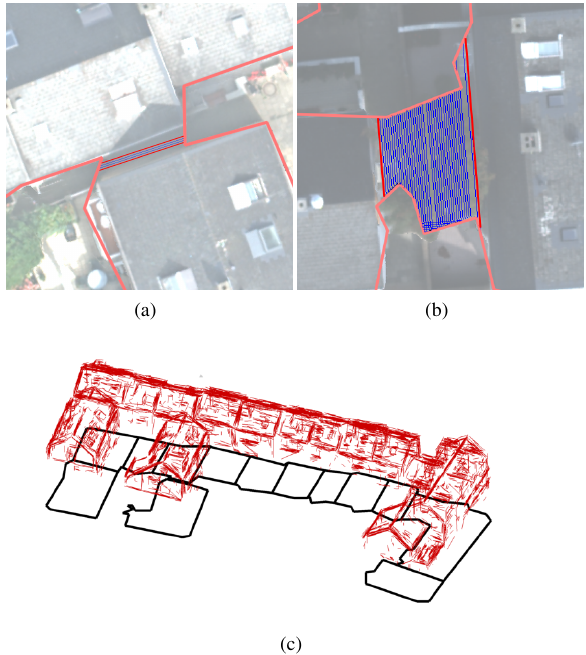
Figure 3. Decomposed building outlines (a-b) Gaps (blue slices) between physically divided houses with new borders (red slices) for initial (pink) building outline (c) Decomposed building polygon (black) based on 3D line segments (red) After the pre-processing steps like line segment detection and fil- tering, the initial polygon is split into 2D slices. Step size and width of the slices is adapted to the ground sampling distance of the vertical input imagery. In the presented case this means in fig- ures 10cm for width and step size, which is twice the given